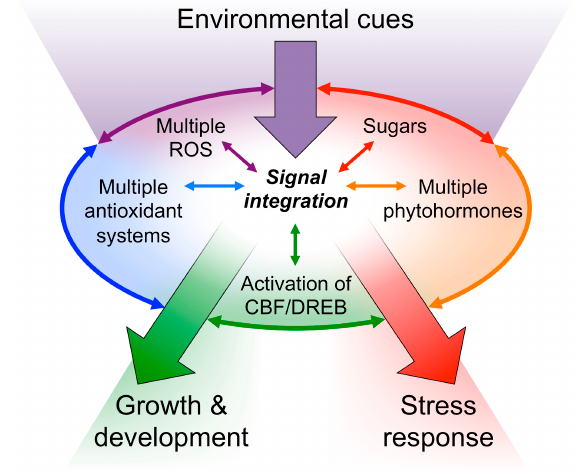
Figure 2. Schematic depiction of prominent signaling pathways involved in translating environmental cues (e.g., light and temperature) into phenotypic responses. cues (e.g., light and temperature) into phenotypic